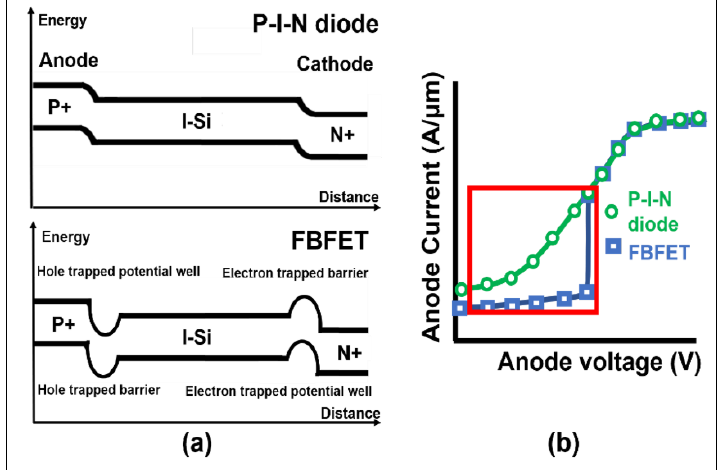
Figure 2. ( a ) Energy band diagram and ( b ) current-voltage characteristics of P-I-N diode and FBFET.